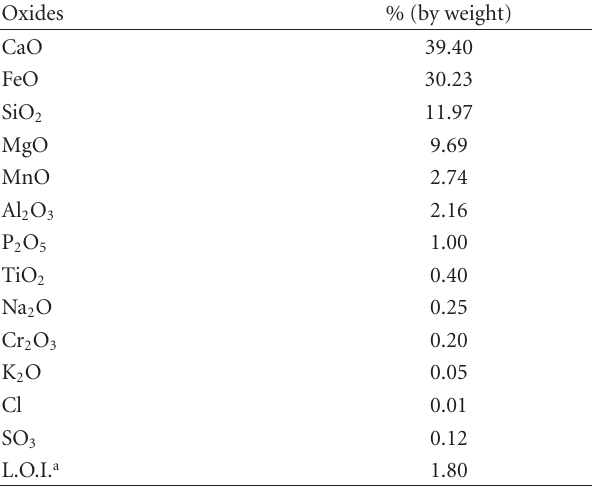
Table 3: Chemical composition of BOF